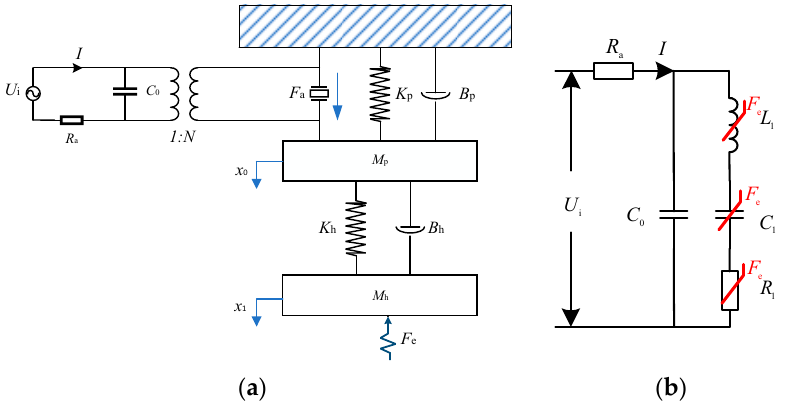
Figure 8. The equivalent model of ultrasonic transducer. ( a ) Dynamic MSD equivalent model; ( b ) Electrical equivalent impedance model.